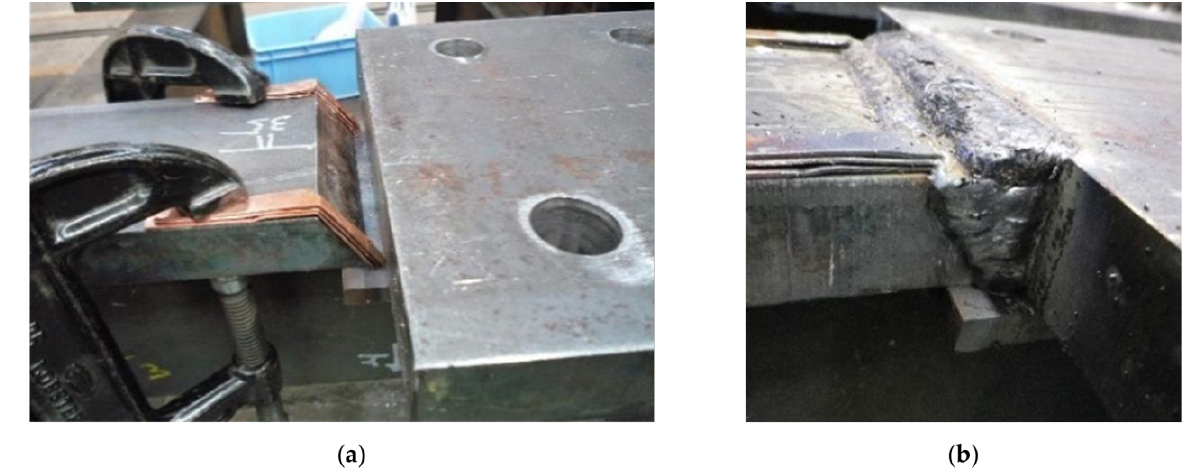
Figure 4. Copper plate insertion of the FTC specimen: ( a ) before and ( b ) after welding.